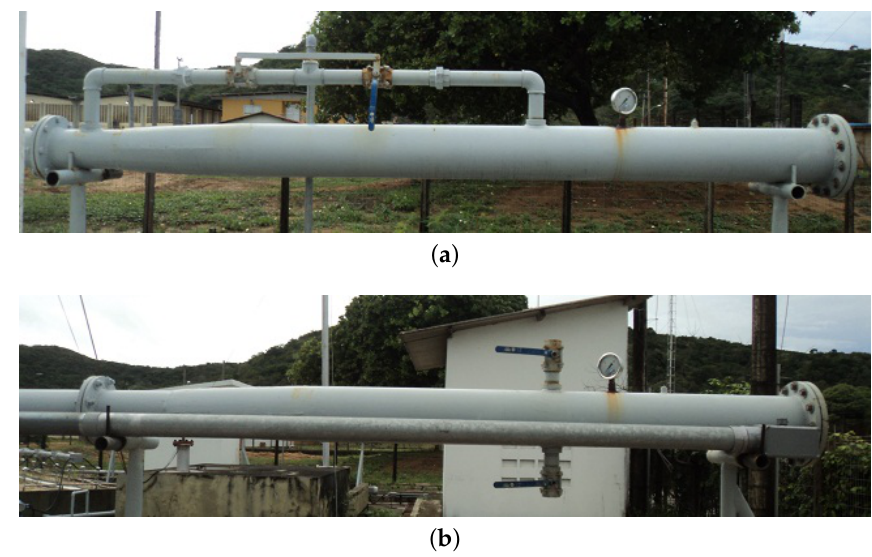
Figure 7. Lateral view. ( a ) lateral view of the φ 8” launcher; ( b ) lateral view of the φ 8” receiver. Source: By authors.